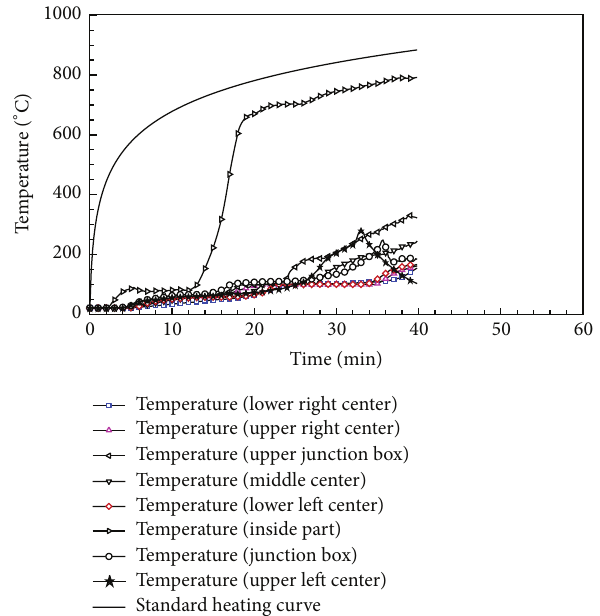
Figure 7: Time-temperature chart for the specimen in Test 3.